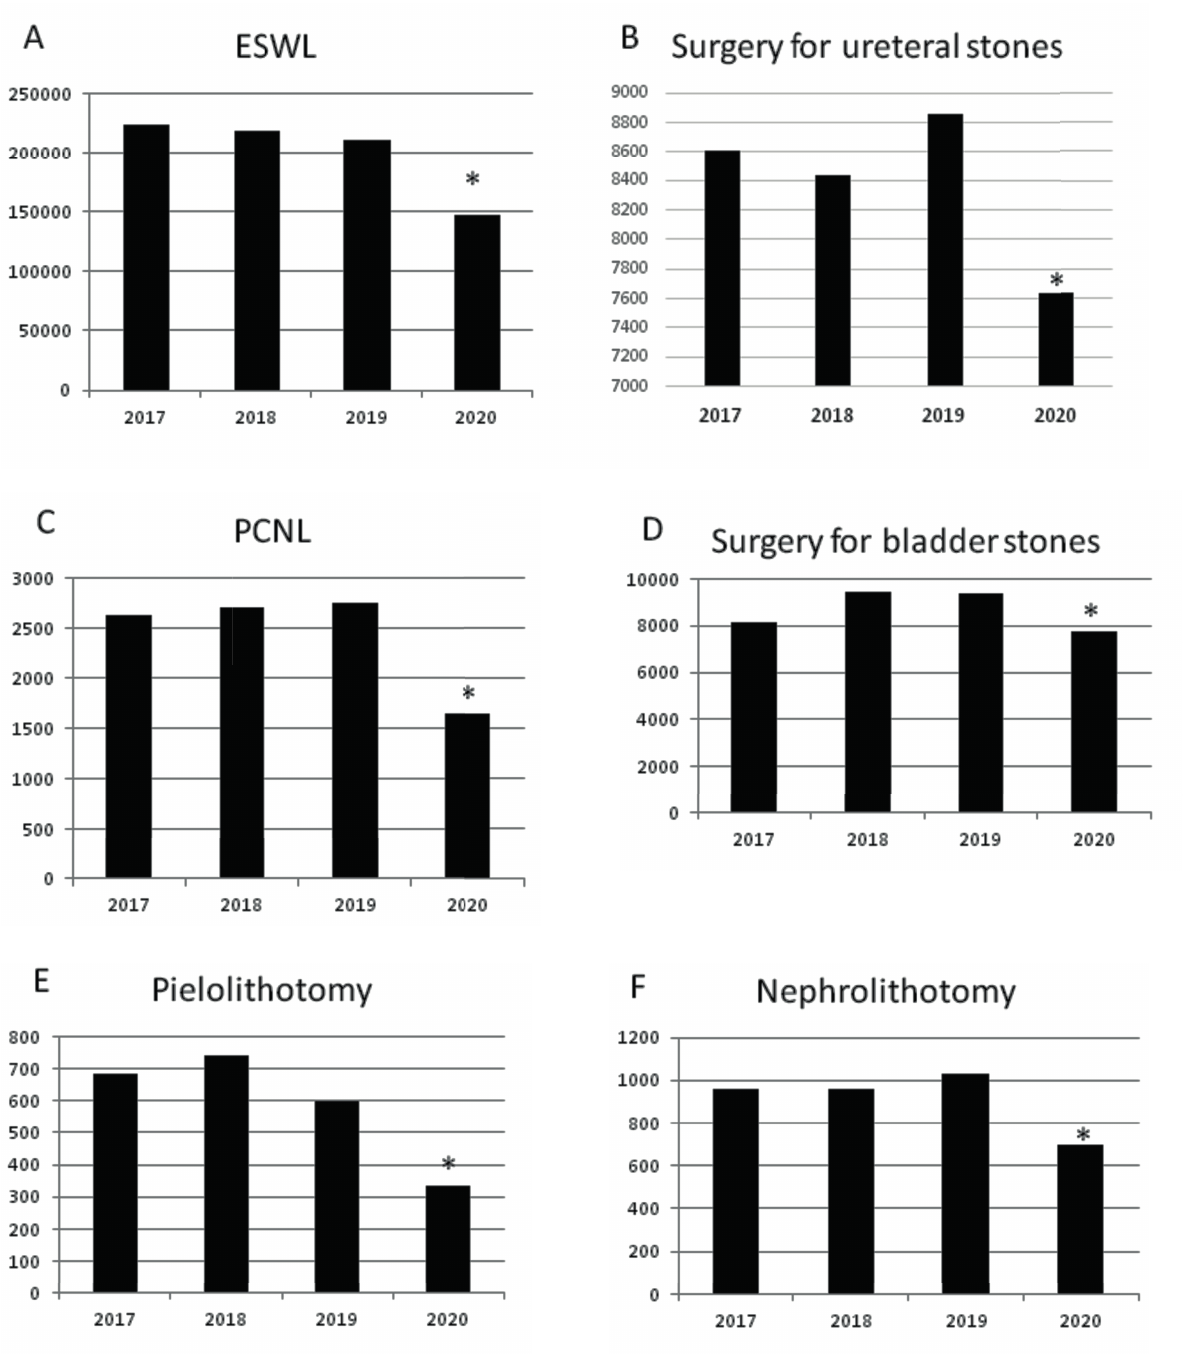
Figure 3 - Frequency of surgical procedures performed (March-February, 2017-2021). The procedures with respectives p-value: Surgeries to remove ureteral (p<.0001), or bladder stones (p<.0001), percutaneous nephrolithotomy (PCNL, p=.043), nephrolithotomy (p<.0001), pyelolithotomy (p<.0001), andextracorporeal shock wave lithotripsy (ESWL)